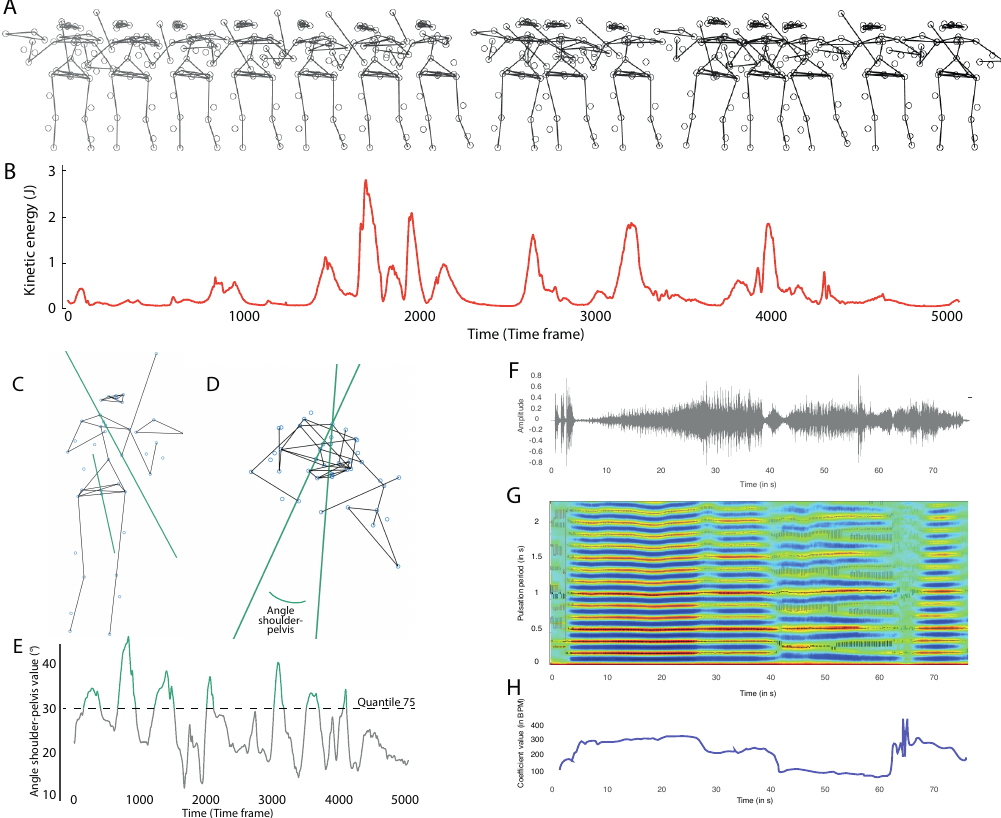
Figure 1. Motion and acoustic features computed: ( A ) Chronograph of the motion capture data for one excerpt played in front of an audience while exaggerating expressive intent. ( B ) Kinetic energy associated with movements of all the markers for the excerpt depicted in ( A ). ( C ) 3D view of the motion capture and the line associated with the pelvis and shoulder. ( D ) Transversal view of the motion capture data and the angle computed between the line from the pelvis and shoulders. ( E ) Computation of Body Twist Index. The angle between the aforementioned lines is computed over the duration of the excerpt. The Body Twist Index consists of the average of all values comprised in the top quantile (above the quantile 75 value). ( F ) Sound profile of the performance of the Scherzo of L. van Beethoven’s Symphony No.9 in D minor, op.125. ( G ) Corresponding autocorrelogram with tracking of the metrical structure. ( H ) Corresponding metrical centroid curve (Copyright Grandjean, D. et al., 2013